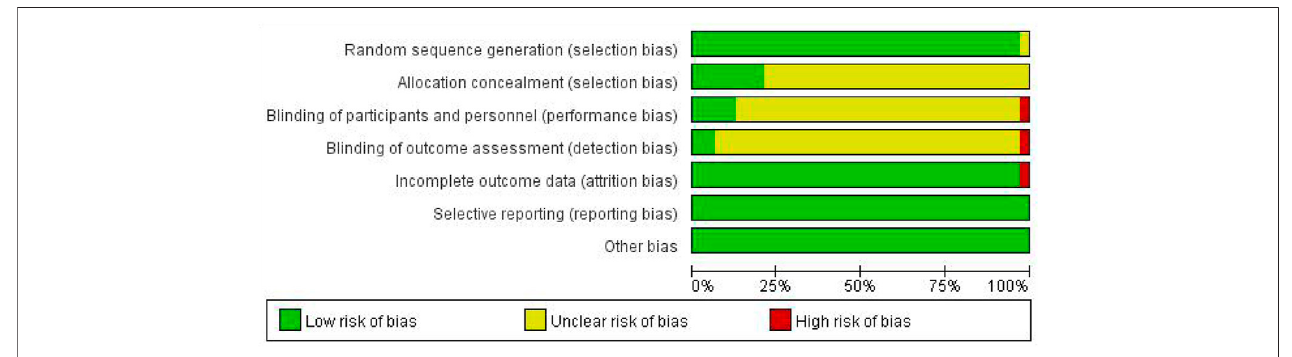
FIGURE 2 | Risk-of-bias